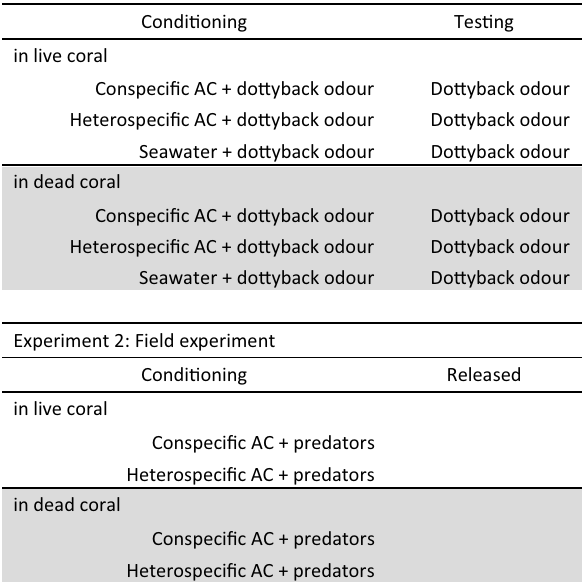
Table 1. Summary of treatment groups in Experiments 1 and 2. Conspecific AC: Alarm cues from P. amboinensis ; Heterospecific AC: Alarm cues from P. chrysurus . Alarm cues and predator odours were prepared with water that matched their respective treatment (see text for details). For experiment 1, we conditioned prey and the following day quantified behaviour (changes in feeding and activity) following exposure to Dottyback odour in the laboratory. For experiment 2, we conditioned prey in live or dead coral to recognize the sight and smell of three common reef mesopredators (Dottyback, Moonwrasse, Lizardfish) in the laboratory and transferred them to patch reefs that were situated 4 m from the continuous reef edge. We quantified behaviour (bite rate, total distance moved, maximum distance ventured from the habitat patch and boldness) and